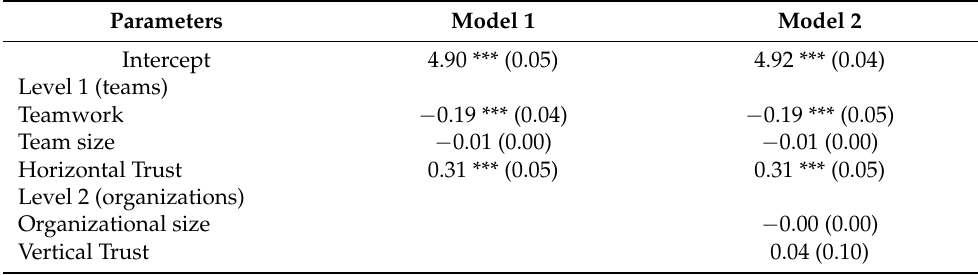
Table 9. Results for the hierarchical linear models predicting performance (ICC =